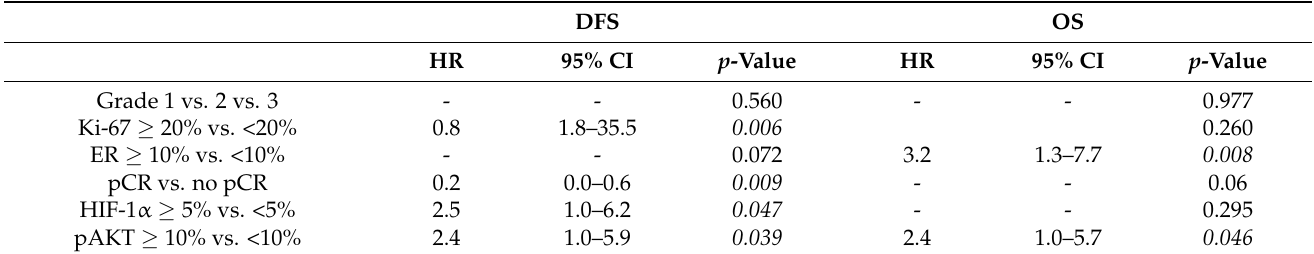
Table 4. Multivariate analysis (Cox regression) of prognostic factors for DFS and OS.